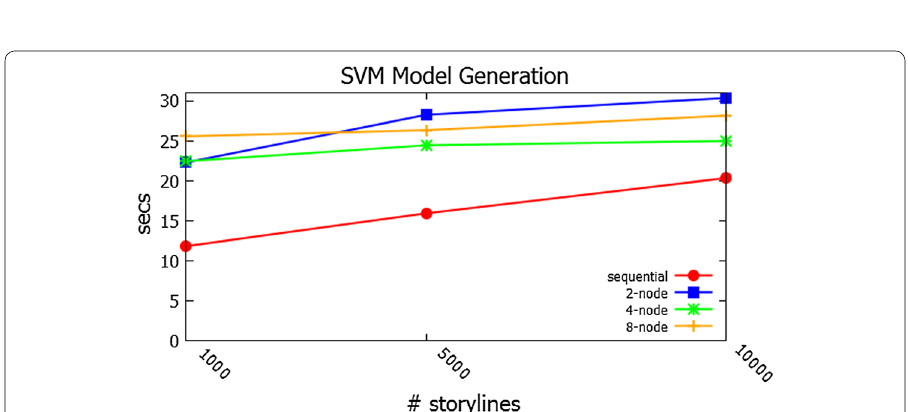
Fig. 6 Performance of training models for multiple bands for sequential and various sized clusters and vari‑ ous training data